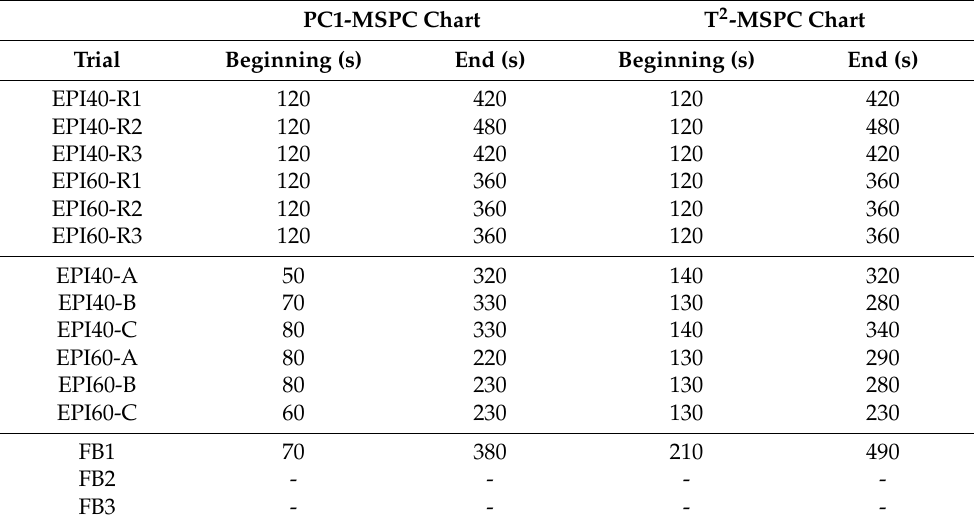
Table 2. Coagulation occurrence time predicted by the developed decision trees based on PC1 and T 2 MSPC charts. PC1-MSPC Chart T 2 -MSPC